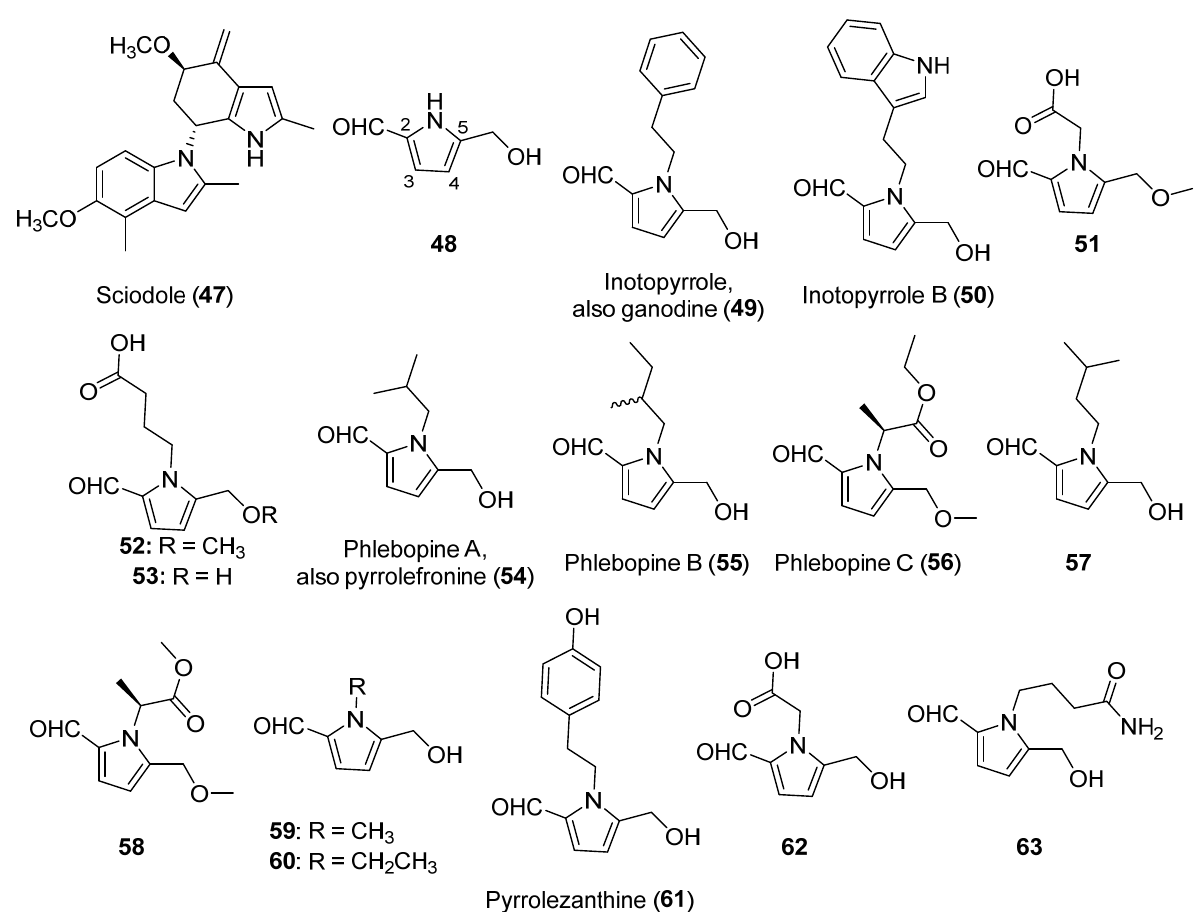
Figure 4. The structures of the pyrrole alkaloids isolated from mushrooms ( 47 – 63